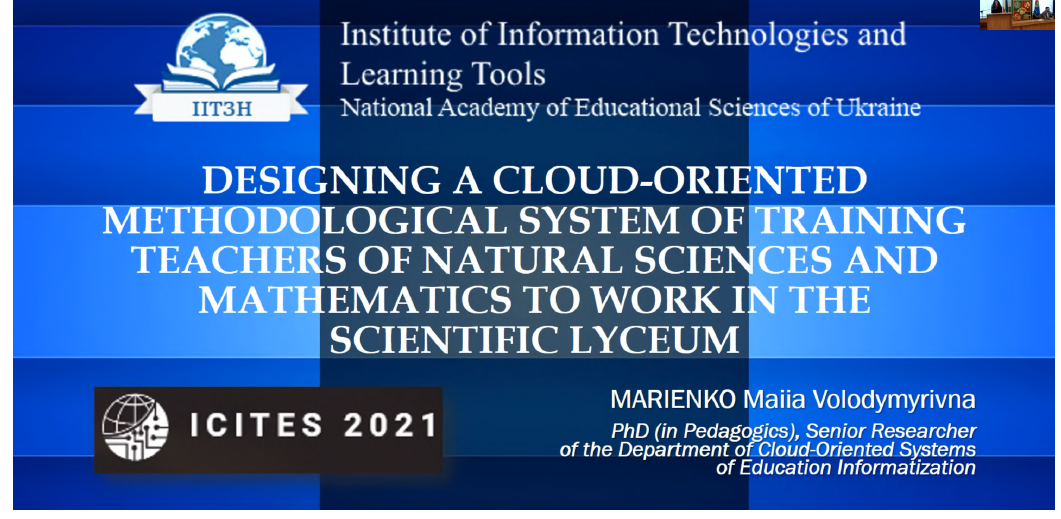
Figure 41: Presentation of paper